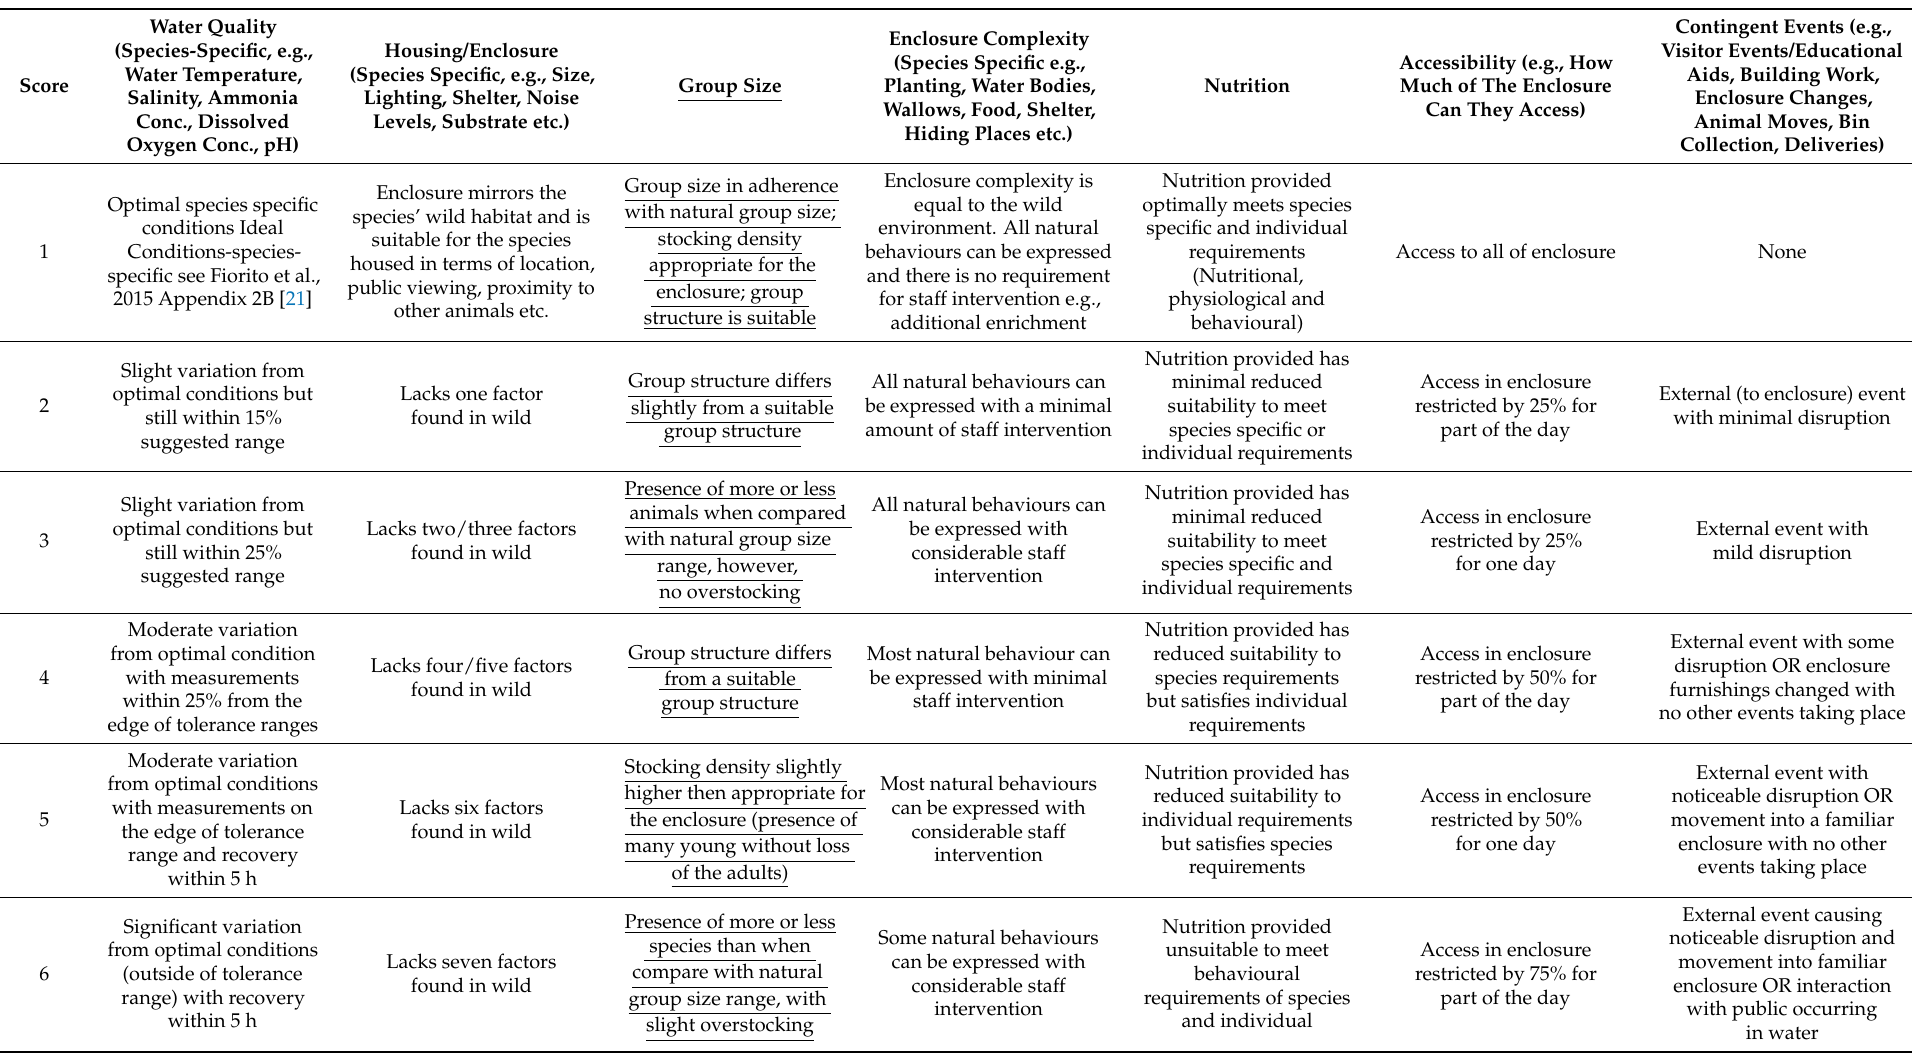
Table 3. Environmental parameter scoring for the AWAG assessment (Underlined—factors assessed in decapods